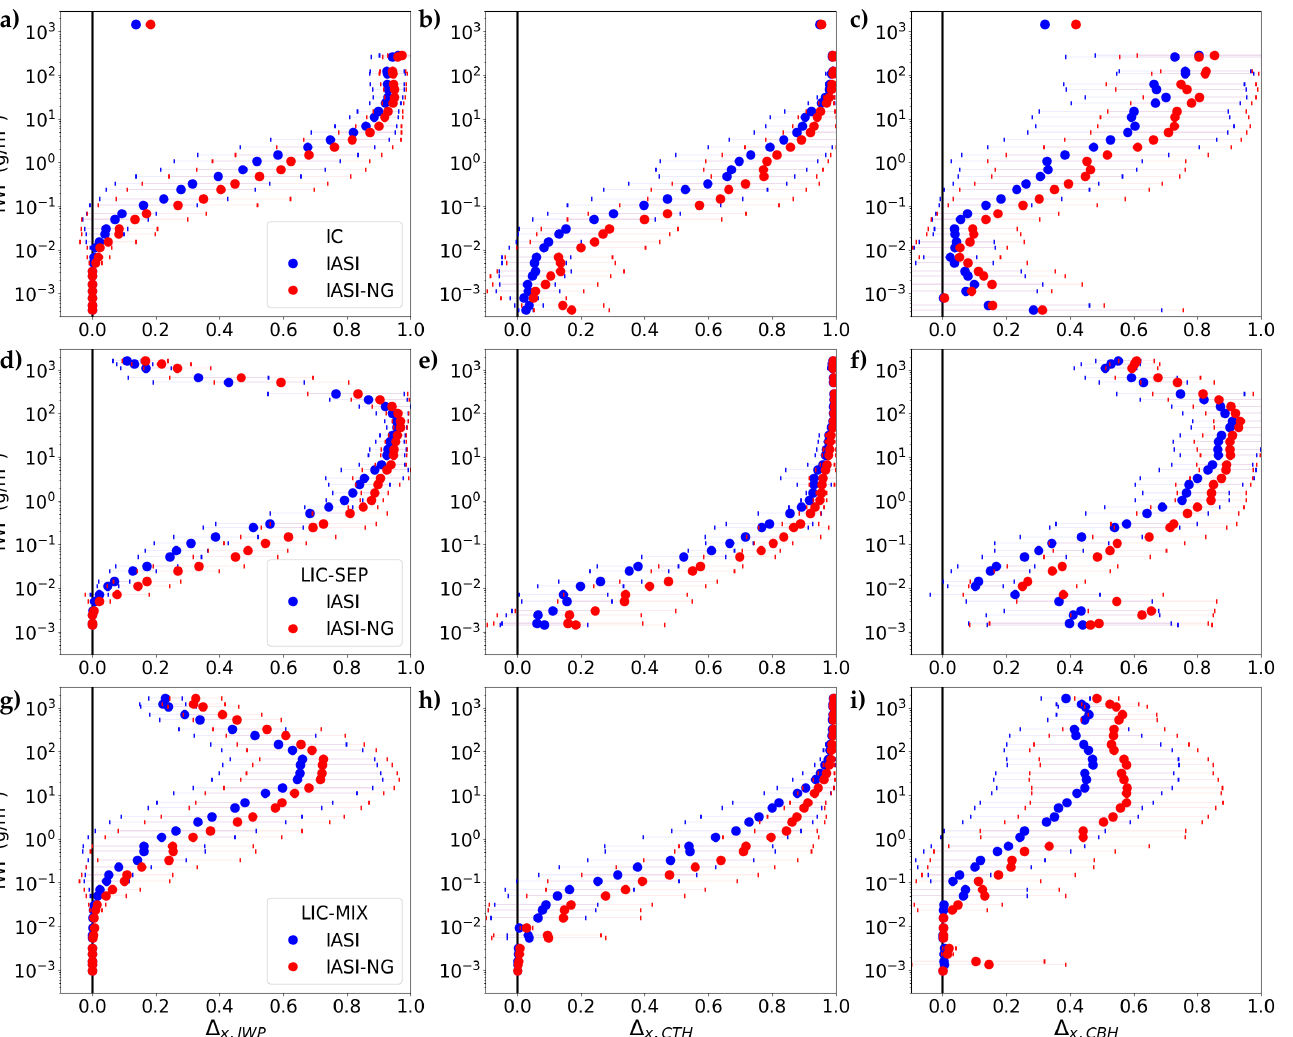
Figure 4. Normalized a priori error departure (difference between the a priori and posterior error normalized by the a priori error) for IWP ( left , a , d , g ), CTH ( center , b , e , h ), and CBH ( right , c , f , i ) for the ice only layer, IC ( upper , a – c ), separated liquid and ice layers, LIC-SEP ( center , d – f ), and mixing liquid and ice layers, LIC-MIX ( lower , g – i ), cloud configurations. The dots stand for the error averaged over IWP bins for the IASI instrumental configuration (in blue) and for IASI-NG (next generation) (red). The x error bars correspond to the standard deviation of the error departure. A value close to 0 implies that the measurement cannot improve our prior knowledge of the parameter. A value close to 1 implies that the parameter can be characterized by the